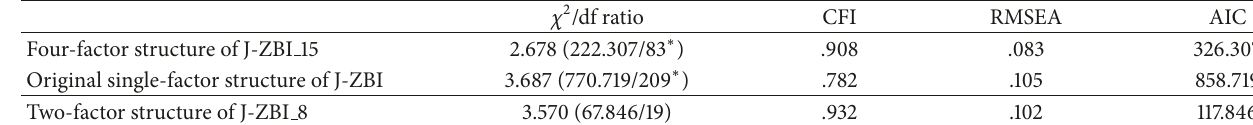
Table 5: The goodness of fit of the models.